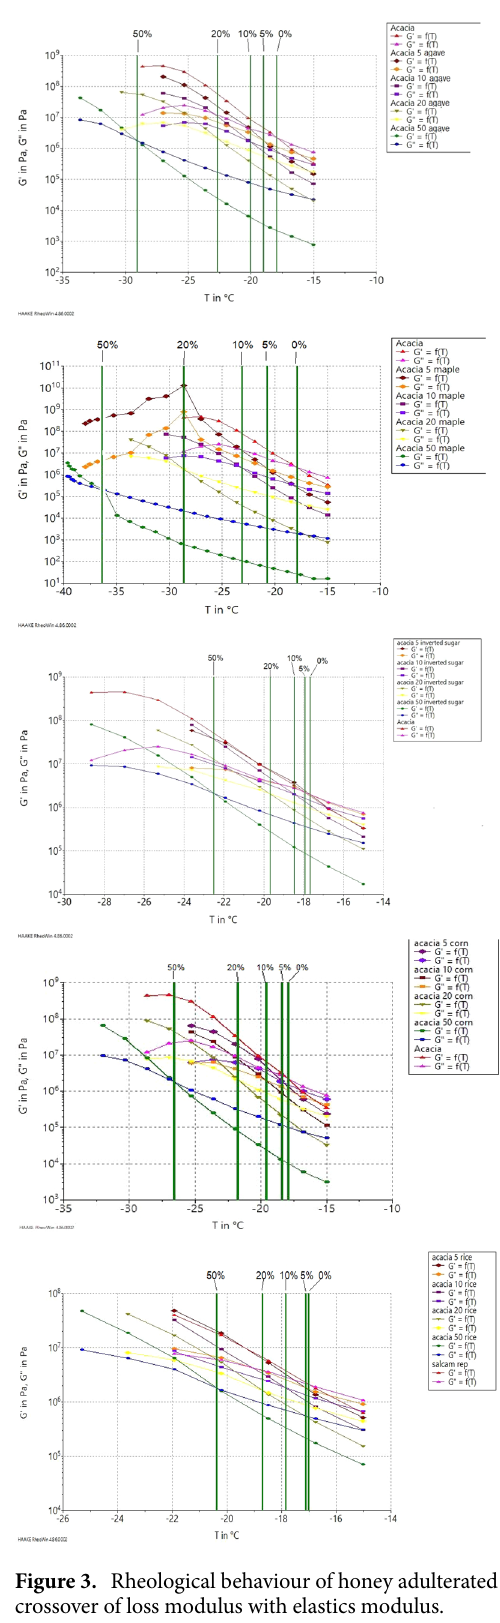
Figure 3. Rheological behaviour of honey adulterated with syrups in the negative temperatures. Green line: crossover of loss modulus with elastics